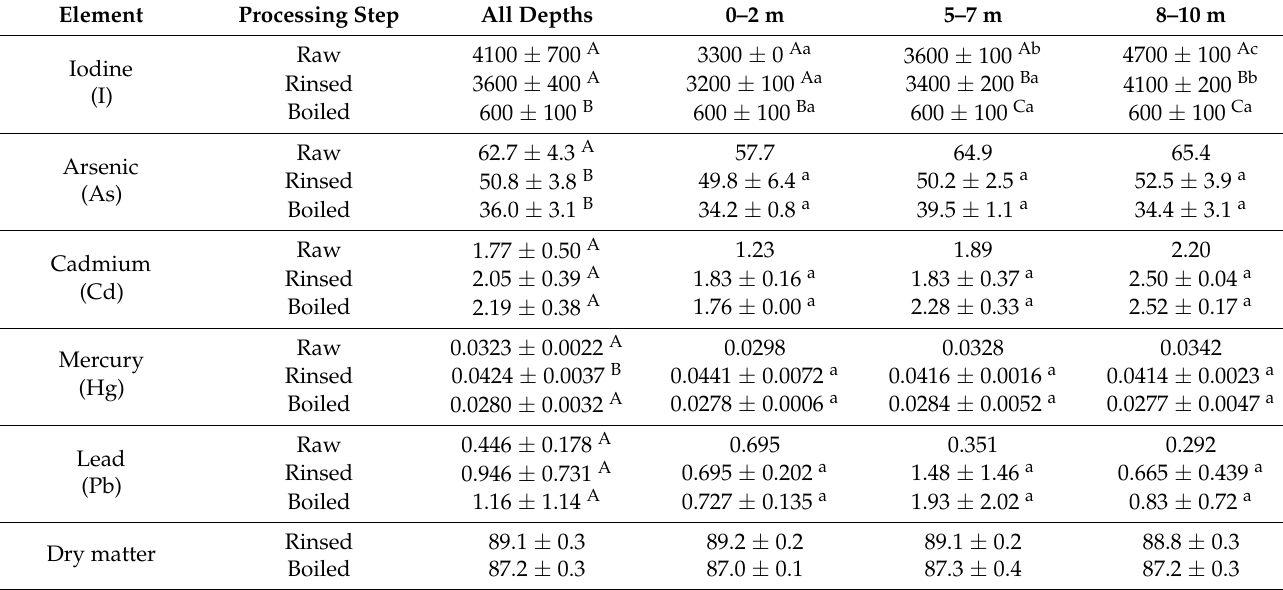
Table 1. The content of PTEs (mg/kg dry weight) and the dry matter content (%) of dried samples of Saccharina latissima cultivated at 0–2, 5–7, and 8–10 m in raw, rinsed, and boiled state. The number of analytical replicates were: Iodine ( n = 3); dry matter ( n = 2); arsenic, cadmium, lead, and mercury ( n = 1). In addition to analytical replicates, sample preparation was conducted in duplicate for processed samples, and thus the number of total parallels was doubled for processed samples ( n = 6, 4, or 2) compared to raw samples ( n = 3 or 1). The data are presented as mean ± standard deviation.